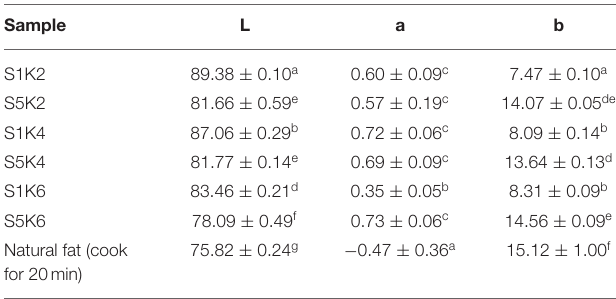
TABLE 4 | The color parameters of the fat substitutes with different protein and konjac content levels and natural meat fat. Sample L a b